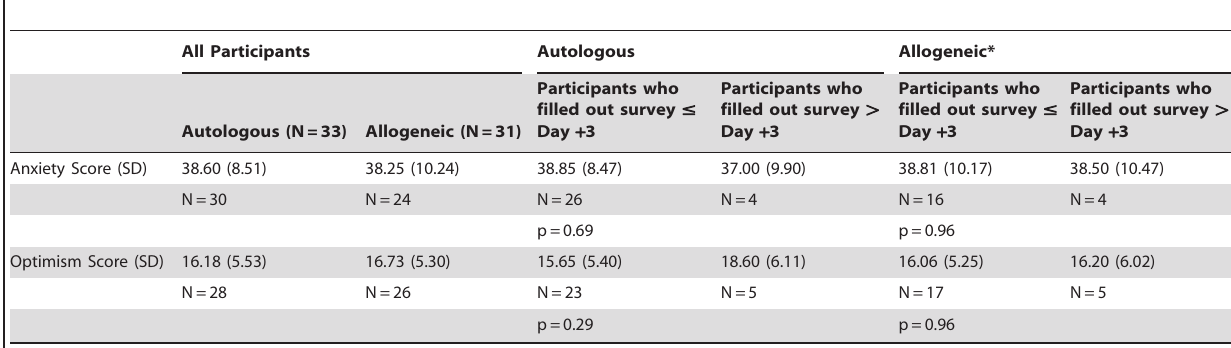
Table 3. Anxiety and optimism scores by type of transplant and as a function of time of survey